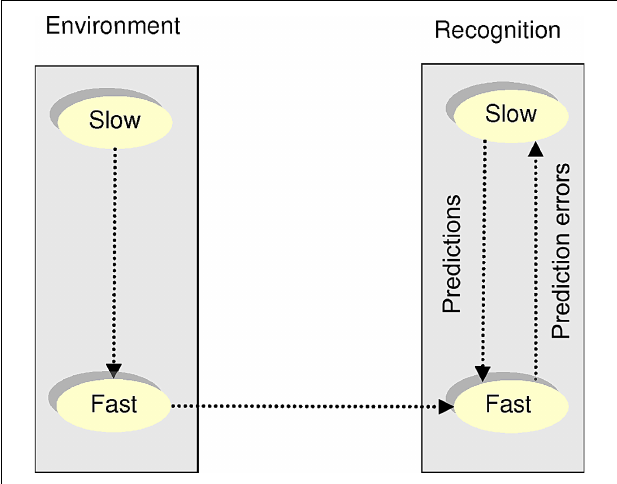
FIGURE 1 | Birdsong generation and its recognition using variational inversion. Environment (left): In this two-level birdsong model, sonograms are generated by the autonomous, coupled dynamics of two Lorenz attractors (see Eqs 1 and 2). The states of the fi rst Lorenz attractor evolve at a slow time scale and act as control parameters for the faster Lorenz attractor. Perception system (right): The implicit variational dynamic inversion is a recurrent message passing scheme, where top-down predictions are sent from the slow level to the fast level, while the fast level receives sensory input and generates bottom-up prediction errors. The resulting recognition dynamics are non-autonomous and try to ‘mirror’ the environmental